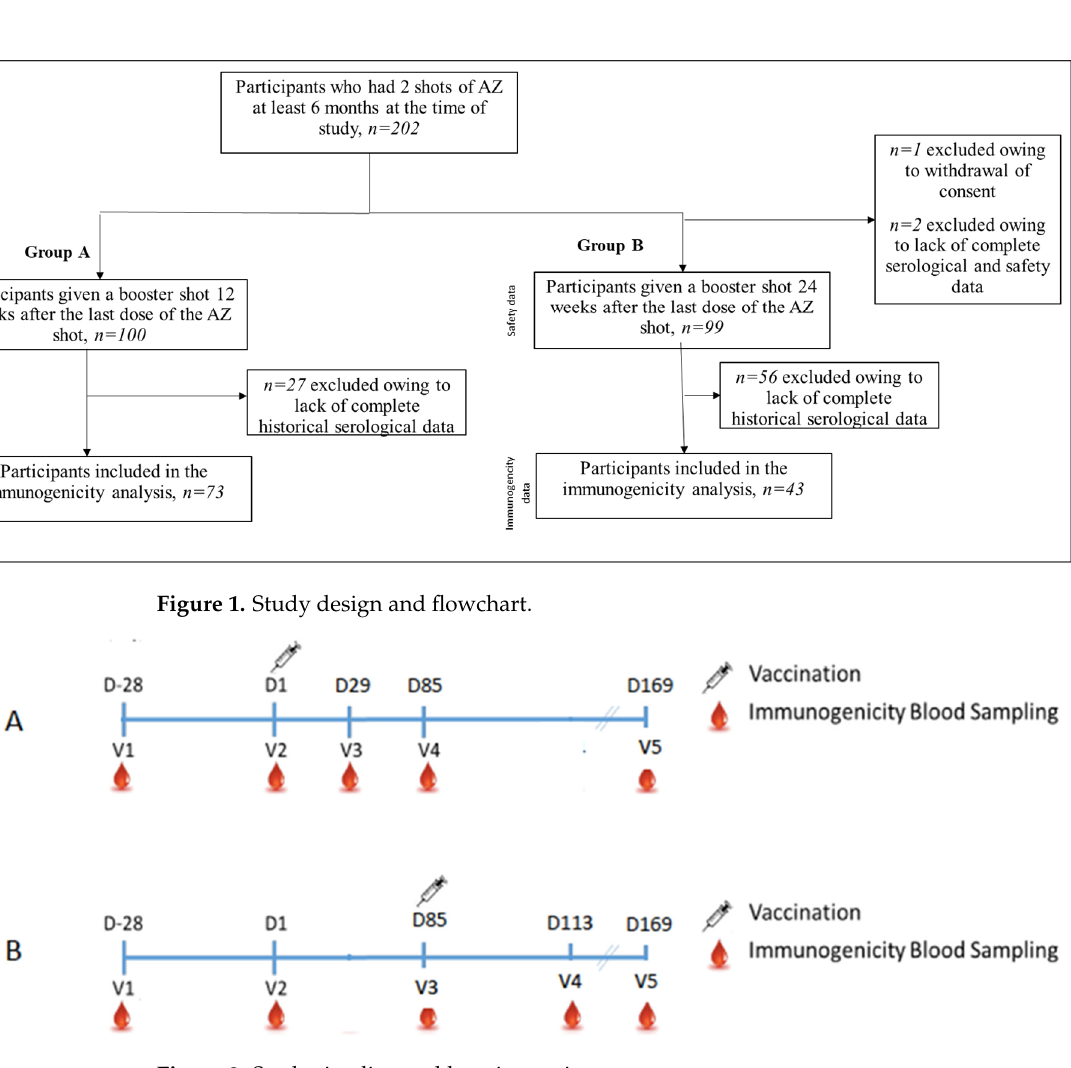
Figure 2. Study timeline and key time points.